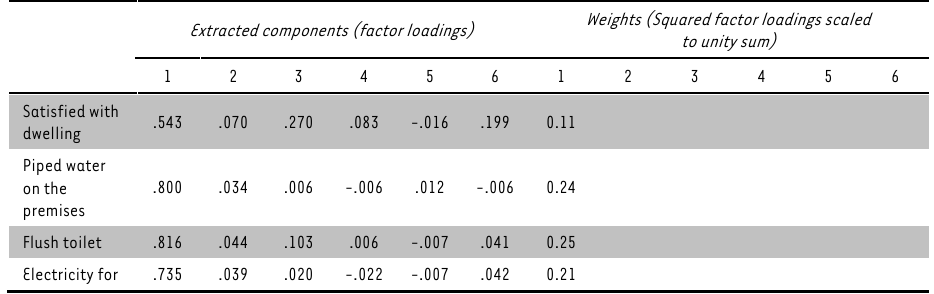
Extracted components, factor loadings and derived weights of the indicators included in the composite quality of life index